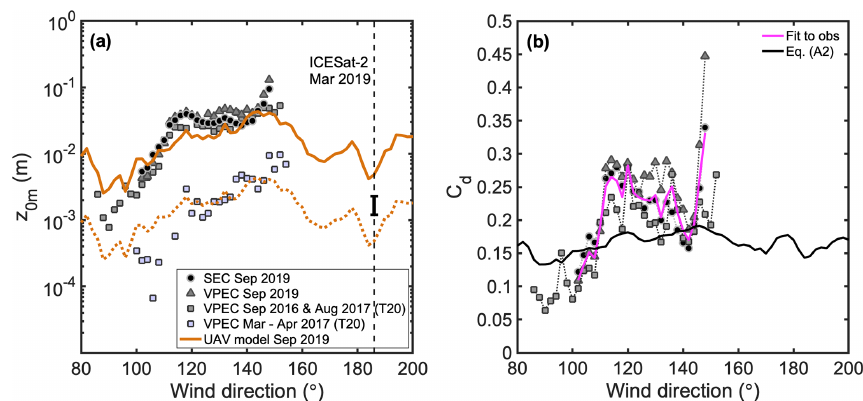
Figure 8. (a) Drag model evaluation at site S5. (b) Drag coefficient for form drag ( C d ) used in the bulk drag model (black line) or required to perfectly fit the observations. The solid orange line is the modelled z 0m using the R92 model and UAV photogrammetry on 6 September 2019, while the dashed orange line is the orange line shifted down by a factor of 10. Solid symbols are measurements from sonic eddy-covariance (SEC) or vertical propeller eddy-covariance (VPEC). Additional data are from Van Tiggelen et al. (2020, T20). The vertical dashed line denotes the direction sampled by the ICESat-2 laser beam on 14 March 2019. The error bar denotes the range between the uncorrected and corrected ICESat-2